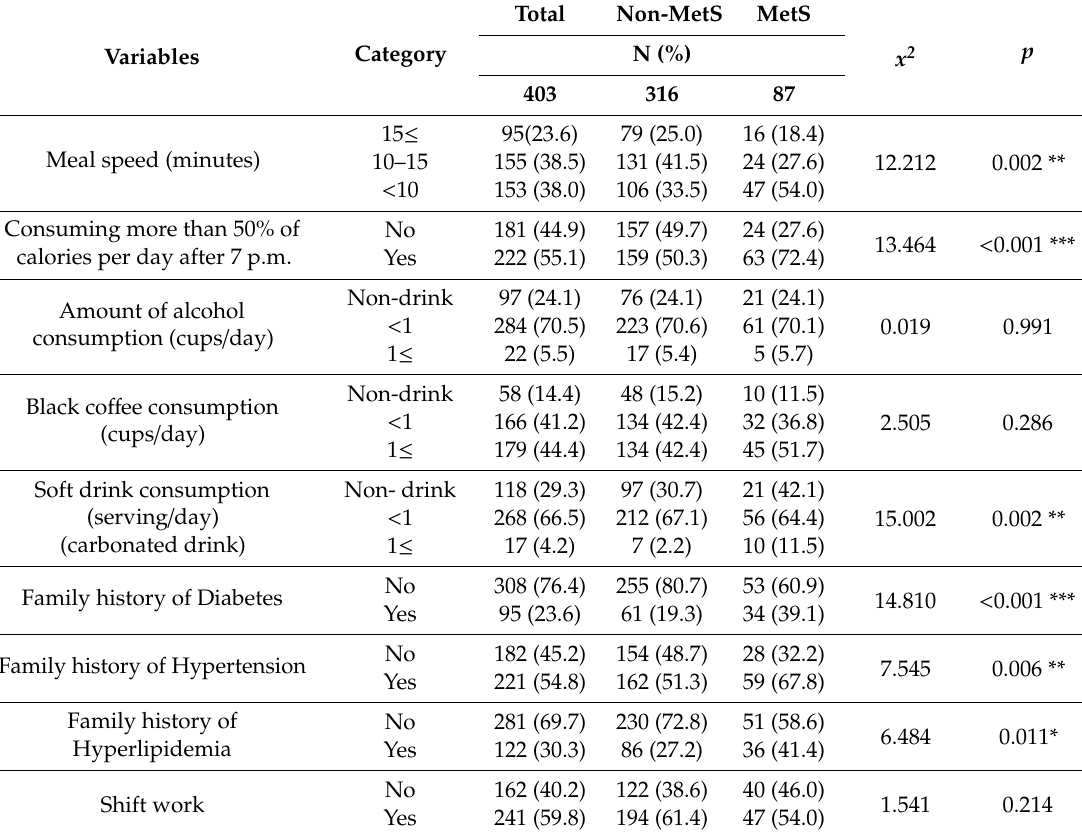
Table 1. General characteristics of participants (N =